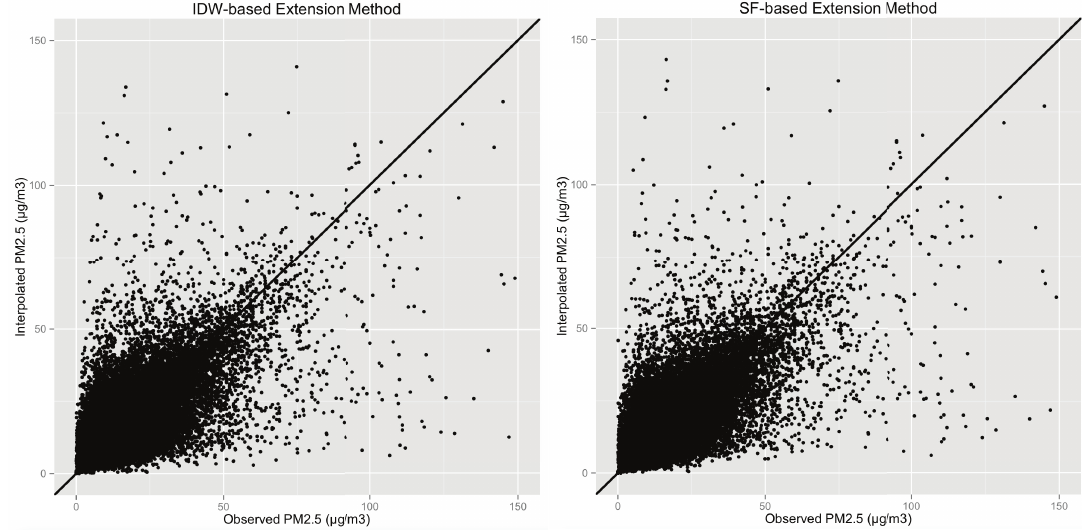
Figure 3. Scattered plots. Comparing observed daily PM 2.5 values with interpolated daily PM 2.5 values across monitoring sites across the contiguous United States in